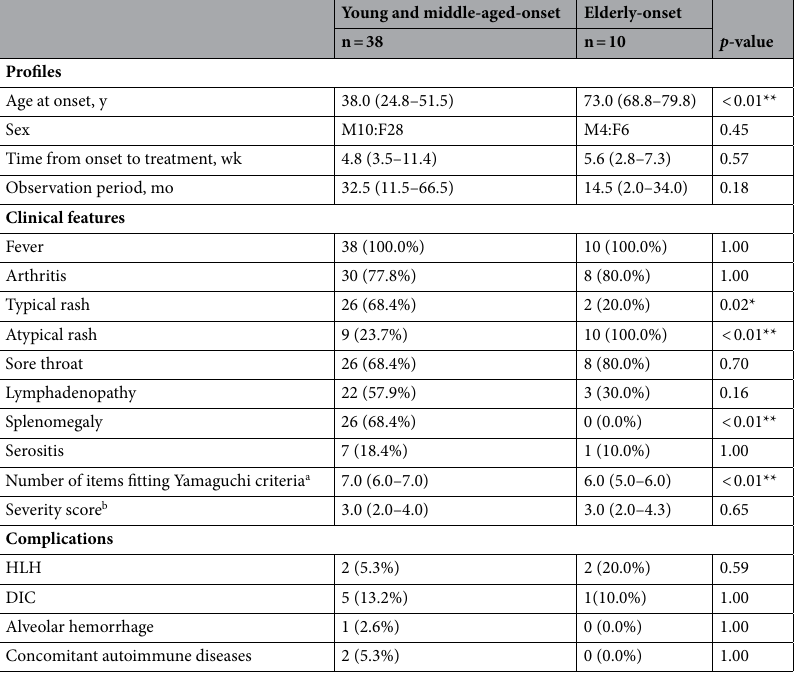
Table 1. Comparison of the characteristics and clinical presentations of the young and middle-aged-onset and elderly-onset groups. HLH hemophagocytic lymphohistiocytosis, DIC disseminated intravascular coagulation. Data represent the median (interquartile range) or numbers of patients. a 8 items in total: 4 major items and 4 minor items. b 0–9 points in total (1 point: serositis, neutrophil ratio ≥ 85%, ferritin ≥ 3000 ng/mL, marked lymphadenopathy and resistance to steroid therapy; 2 points: DIC and HLH). p -value: Fisher exact test for categorical variables and Mann–Whitney U test for continuous variables. *Significant value ( p < 0.05). **Significant value ( p < 0.01).